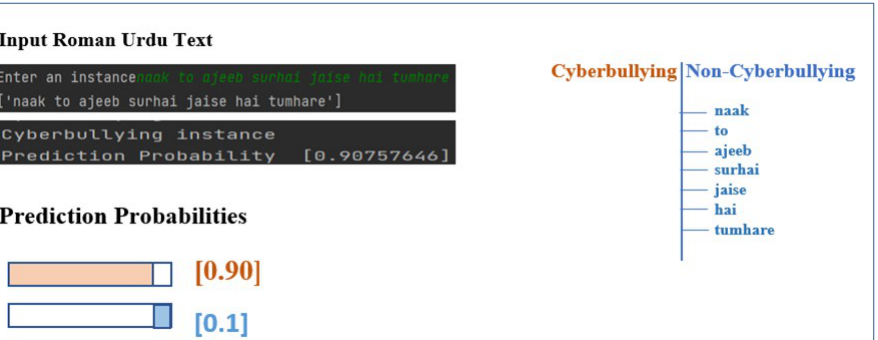
Figure 15. Prediction probability score for implicit Roman Urdu